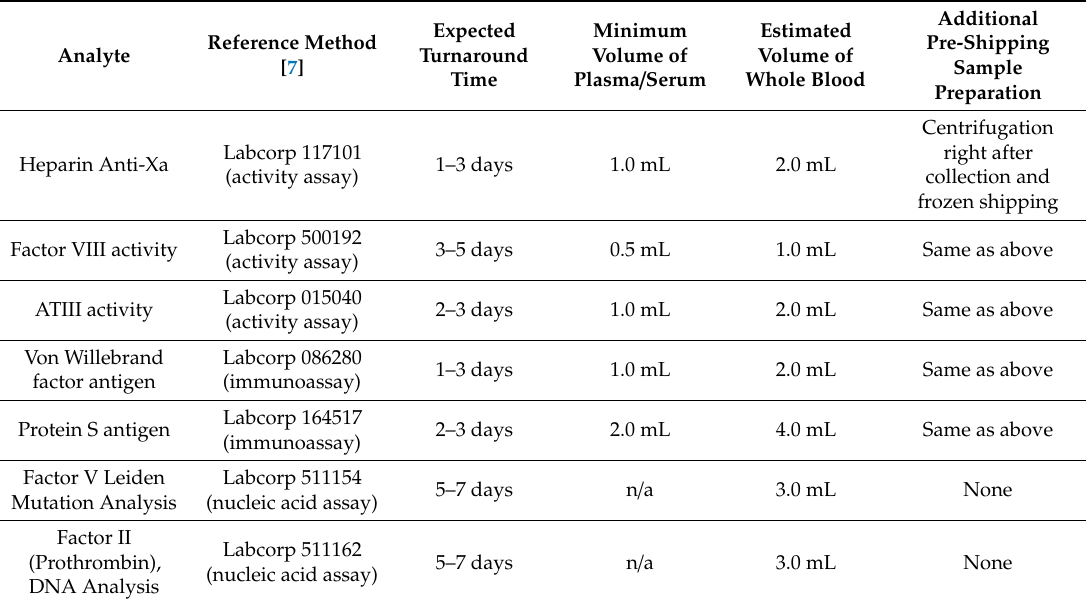
Table 1. Requirements for routine coagulation